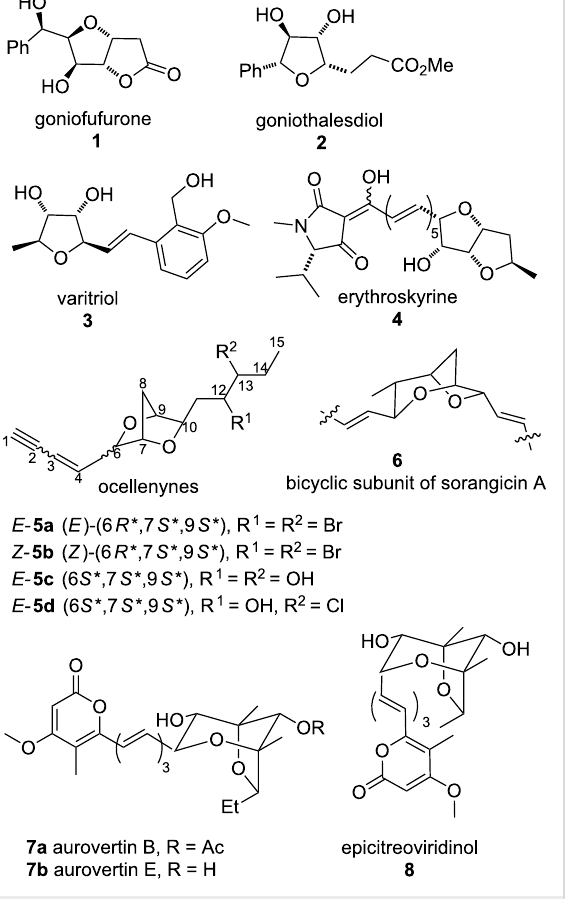
Figure 1: Examples of naturally occurring tetrahydrofurans.